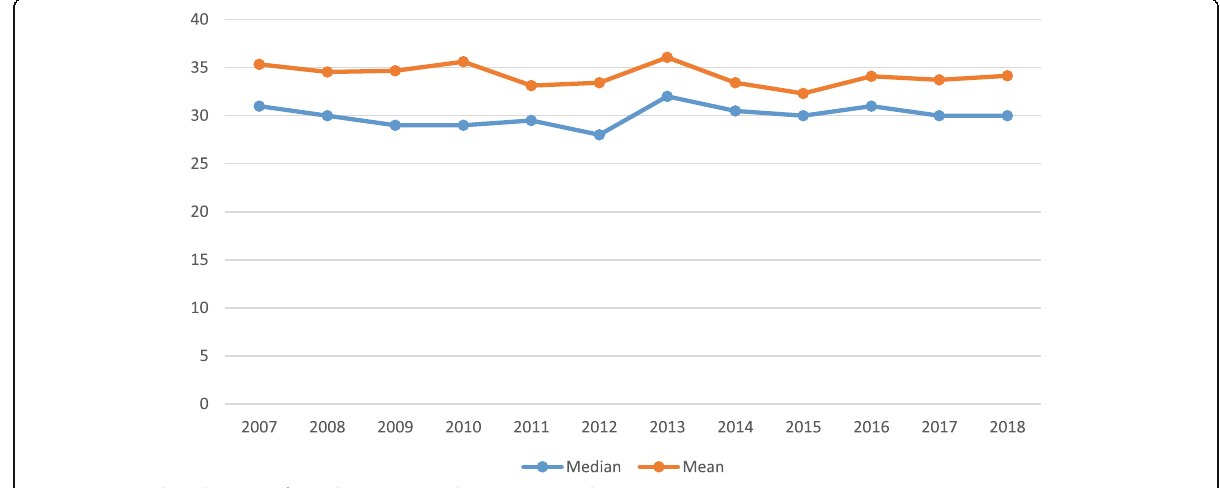
Fig. 1 Mean and median age of suicides in East Azerbaijan Province during 2007 – 2018 ( P =